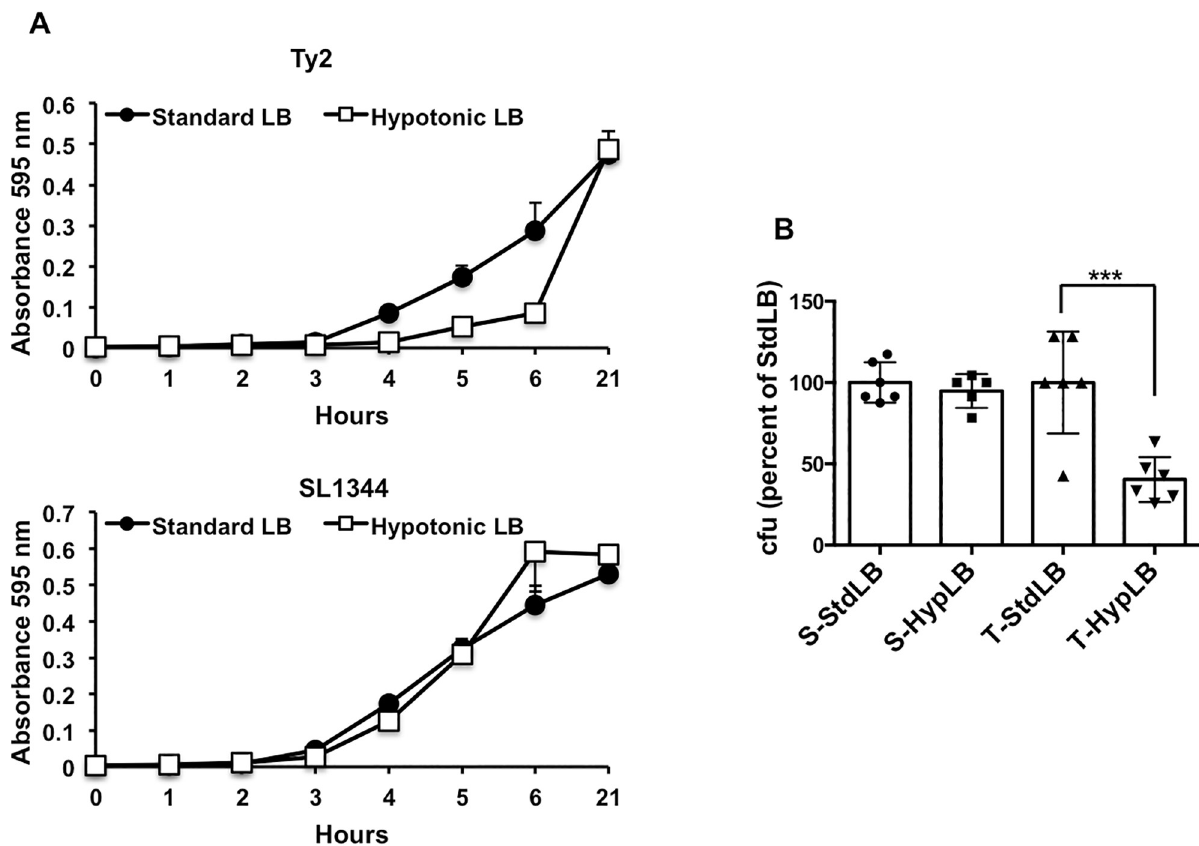
Fig 3. Growth of Ty2, but not SL1344, is impaired by hypotonic conditions. A. Overnight shaking cultures of Ty2 and SL1344 were diluted 1000-fold into fresh medium, either standard LB or hypotonic LB, and the bacteria were grown at 37˚C with shaking at 220 rpm. Growth curves were generated as described in the methods section. B. Overnight shaking cultures of Ty2 (T) and SL1344 (S) were diluted 1000-fold into fresh medium, either standard LB (StdLB) or hypotonic LB (HypLB), and the bacteria were grown at 37˚C with shaking at 220 rpm for 6 hours. The number of viable bacteria in each condition at that time point was determined and expressed as a percentage of the number in standard LB. ��� p = 0.0001, n = 5 or 6 per group.